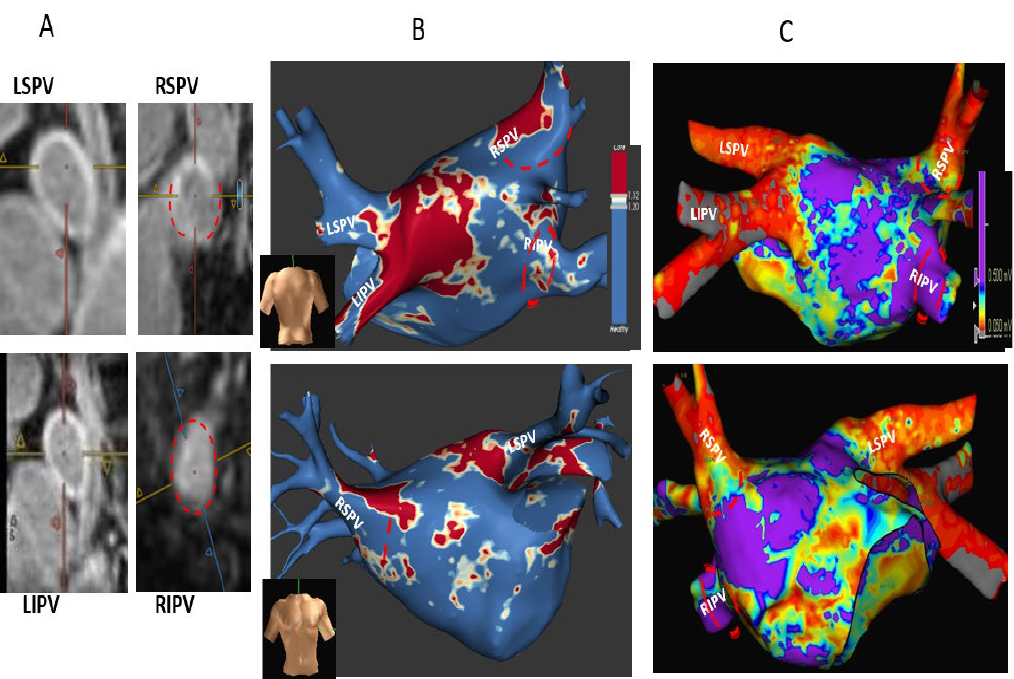
Figure 5. Correlation of post-index-ablation MRI to redo procedure electro-anatomic mapping (EAM): Major PV gaps around both right PVs (upper-posterior views, lower-anterior views). Post-index-ablation MRI cross-sectional short-axis views (“raw data” images) ( A ), post-index-ablation MRI ADAS 3D model ( B ), and redo procedure EAM (Ensite Precision system) ( C ) all show complete circumferential PV ostial fibrosis around the main branches of a left common PV (marked as LSPV and LIPV); presence of major gaps in RSPV anterior, inferior, and posterior walls (marked by red dotted lines); and almost absent ostial fibrosis around RIPV (red dotted lines). Good correlation was found between post-ablation MRI and redo EAM regarding PV ostial scar and major gap locations (marked by red dotted lines in both MRI and EAM images).